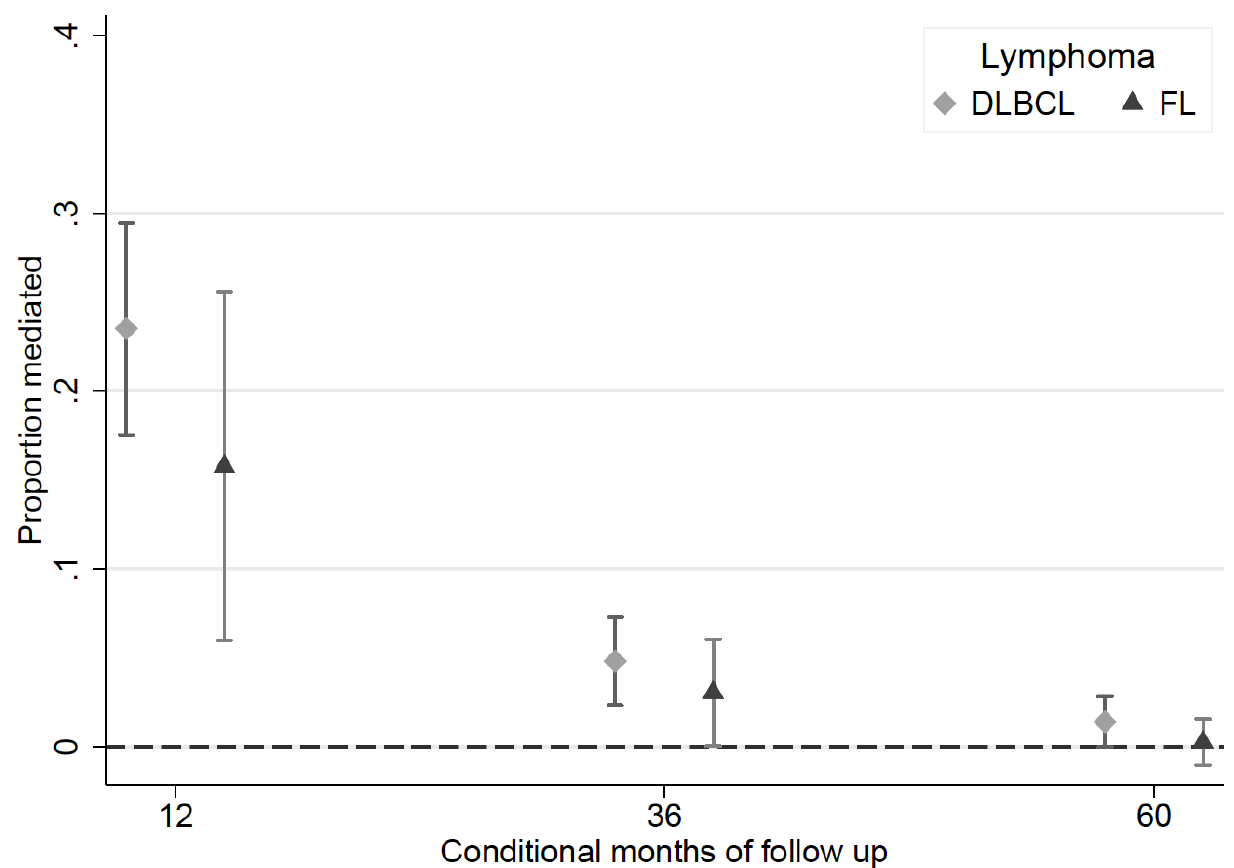
Figure 5. Proportion of the effect of comorbidity status on survival mediated by diagnostic route amongst patients diagnosed with DLBCL ( n = 27,379) or FL ( n = 14,043) in England between 2005 and 2013.